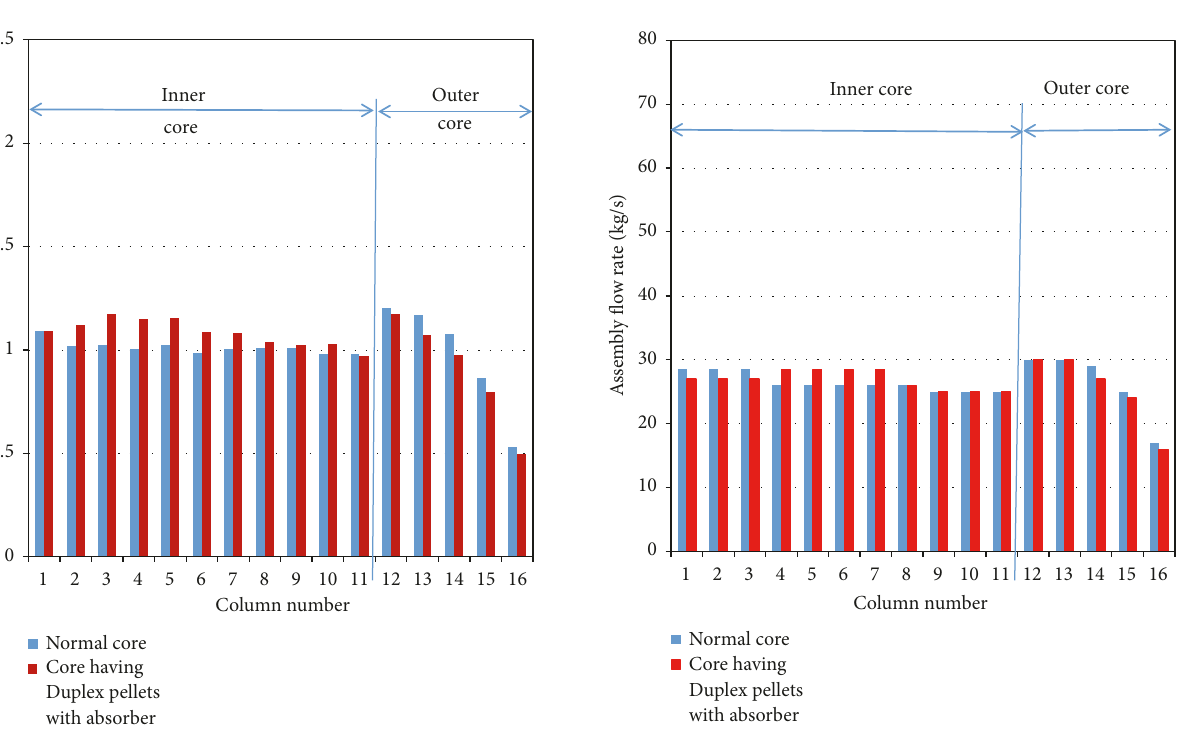
Figure 4: Comparison of assembly power between the normal core without Duplex pellets and the core having Duplex pellets with neutron absorber. The difference in the assembly power between both cores is insignificant.